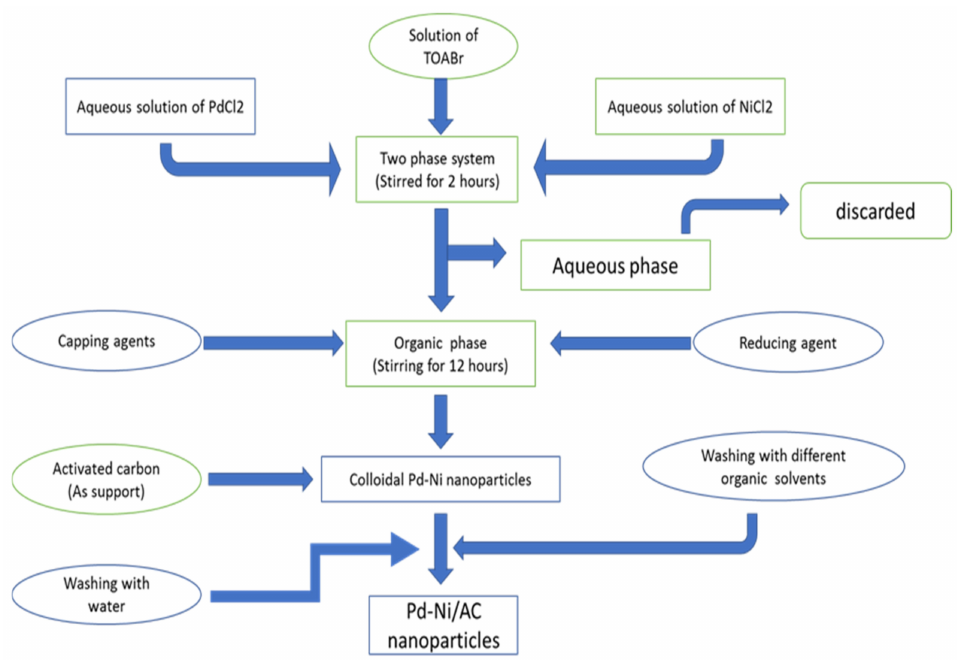
Figure 2. Synthesis of Pd–Ni supported on activated